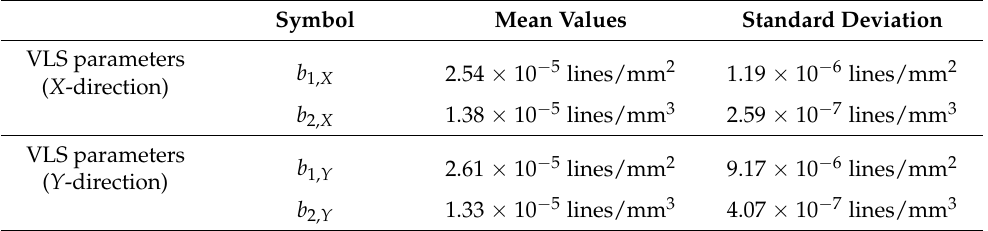
Table 2. Evaluated VLS parameters of the large-scale VLS grating. (Two-dimensional area analysis).